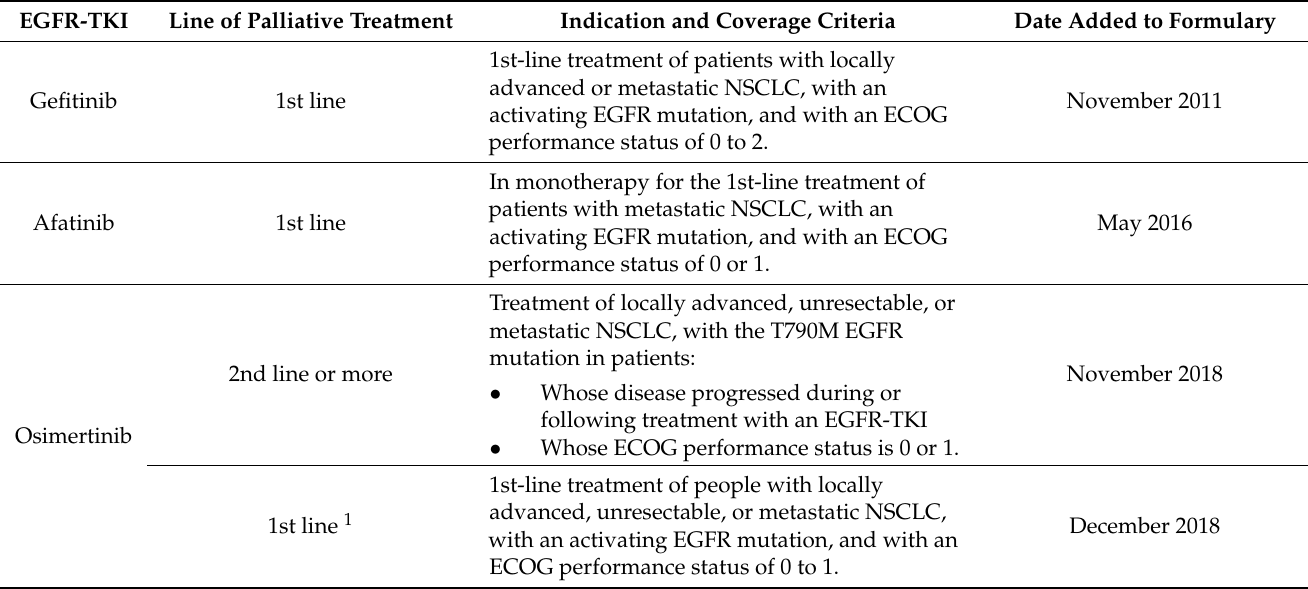
Table 1. Indications for gefitinib, afatinib, and osimertinib included in the drug formulary of Quebec’s universal public drug coverage program